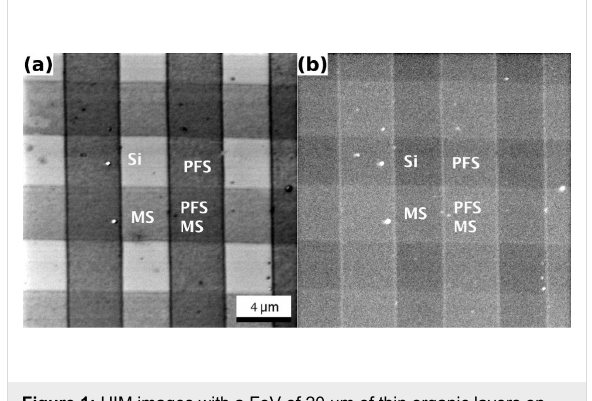
Figure 1: HIM images with a FoV of 20 μ m of thin organic layers on Si{001}. Data was recorded with a PE of 15 keV, and an ion dose of